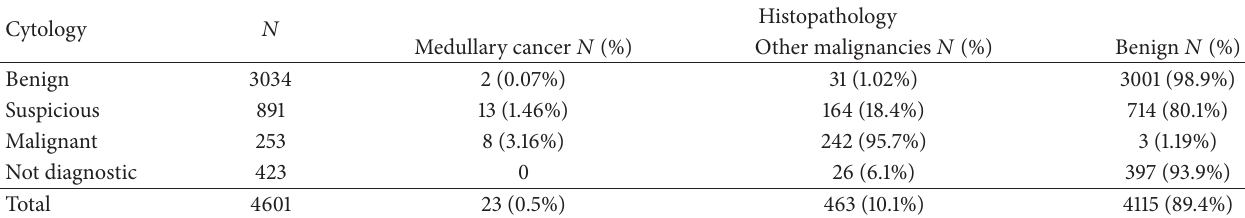
Table 2: Cytohistological comparison in medullary and nonmedullary thyroid carcinomas. Cytology